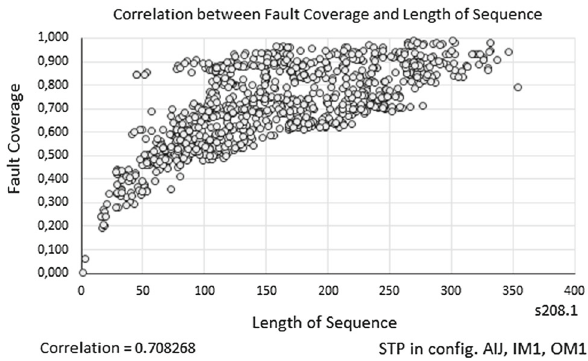
Fig. 15 Correlation between the length of sequence and FC for s208.1 circuit. ATS configuration ID from 1 to 100 (Fig. 9)